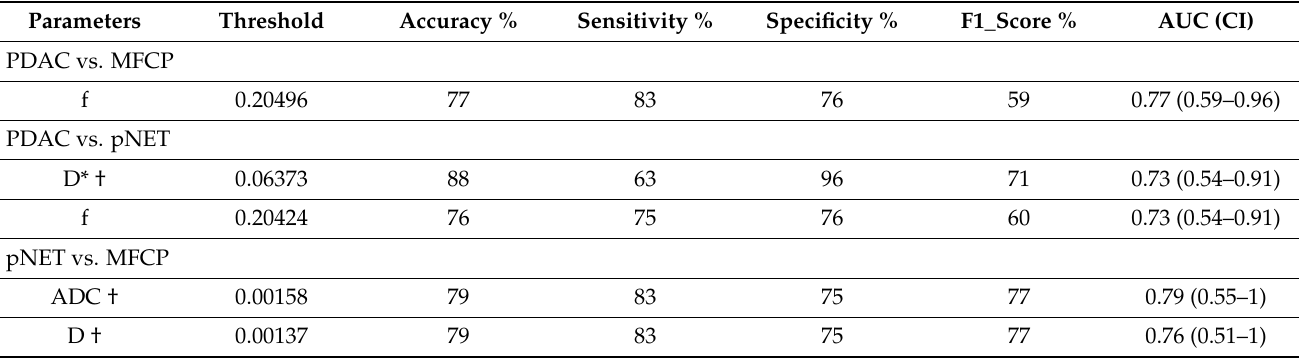
Table 4. ROC analysis of characterizing pancreatic masses using ADC and IVIM-DKI parameters quantified using IDTV